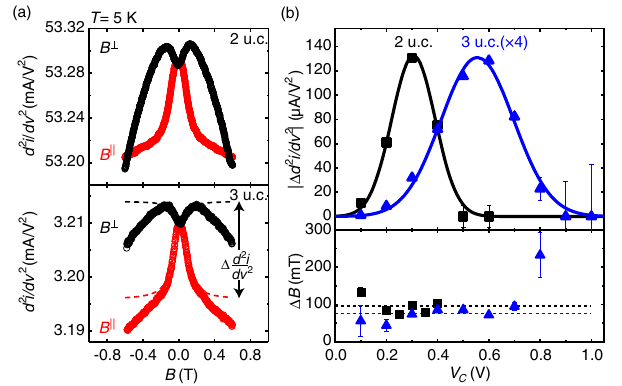
FIG. 3. Magnetic-field-modulated inelastic electron tunneling spectroscopy. (a) Magnetic field dependence of d 2 i=dv 2 for ¼ 2 and 3 u.c. for B ⊥ (black circles) and B ∥ (red circles). t LAO ¼ 0 . 3 V, dv ¼ 50 mV, and The bias state for 2 u.c. is V C ¼ 0 . 4 V, dv ¼ 50 mV for 3 u.c. (b) Top panel: V C j Δ d 2 i=dv 2 j for the 2 u.c. (black squares) and 3 u.c. (blue triangles) LaAlO 3 tunnel barriers. Measured at fixed ac voltage, dv ¼ 50 mV and T ¼ 5 K. Bottom panel: Corresponding line- widths